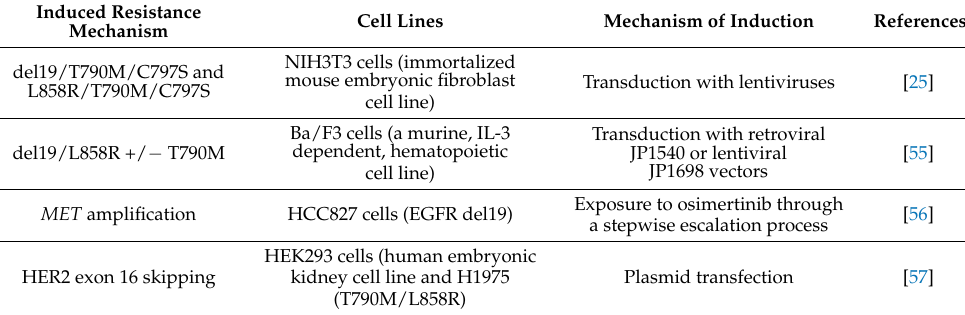
Table 2. Cell lines used to study resistance to